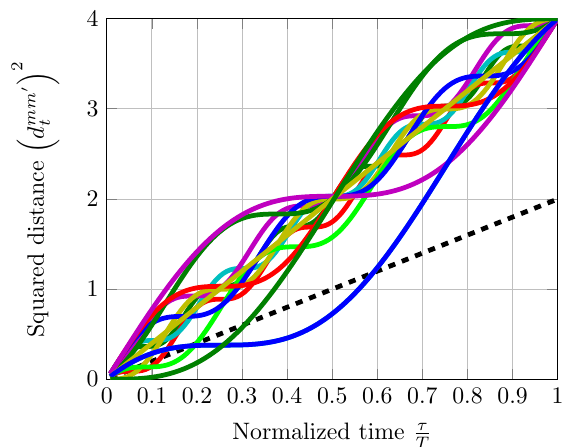
Fig. 8 Distances over time between OFDM signals with 128 subcarriers and where codewords are mapped to a QPSK modulation. Number of different symbols in codewords # K = 1 represented by the black dashed curve; number of different symbols in codewords # K = 2 represented by colored